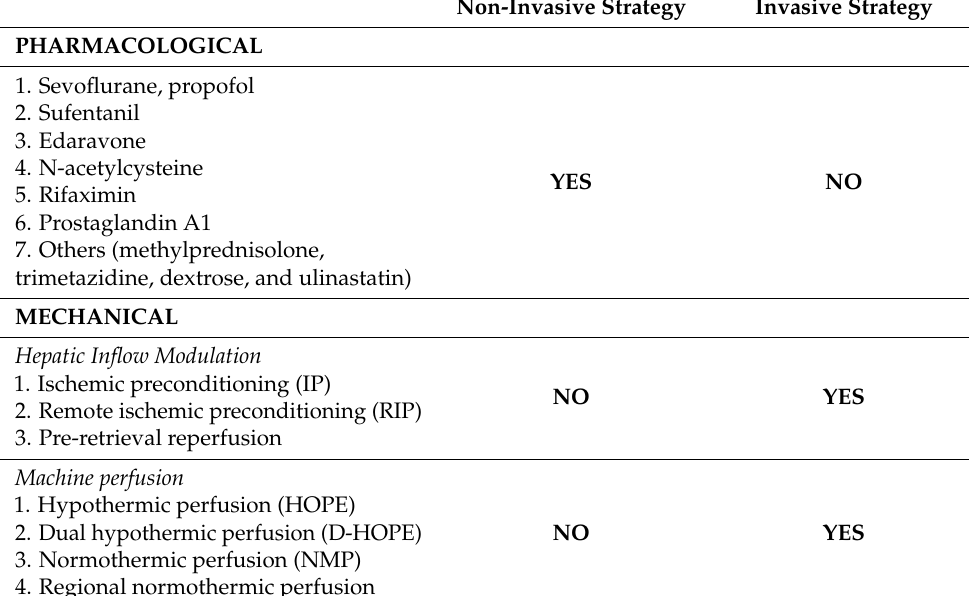
Table 1. Summary of the different strategies employed to mitigate ischemia-reperfusion